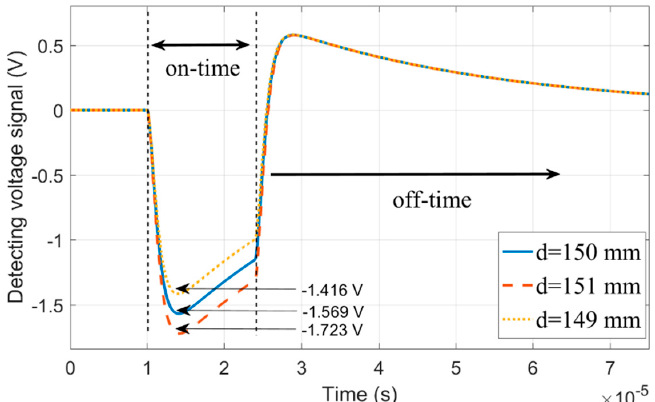
Figure 7. Detected signal versus time for three different d values. The output voltage signals of the RX coil corresponding to d = 150 mm, d = 151 mm, and d = 149 mm are respectively plotted by the solid blue line, the red dotted line, and the yellow dotted line, with the peak voltages 𝑈 𝑝 = −1.569 V , 𝑈 𝑝+ = −1.723 V , and 𝑈 𝑝− = −1.416 V , respectively.